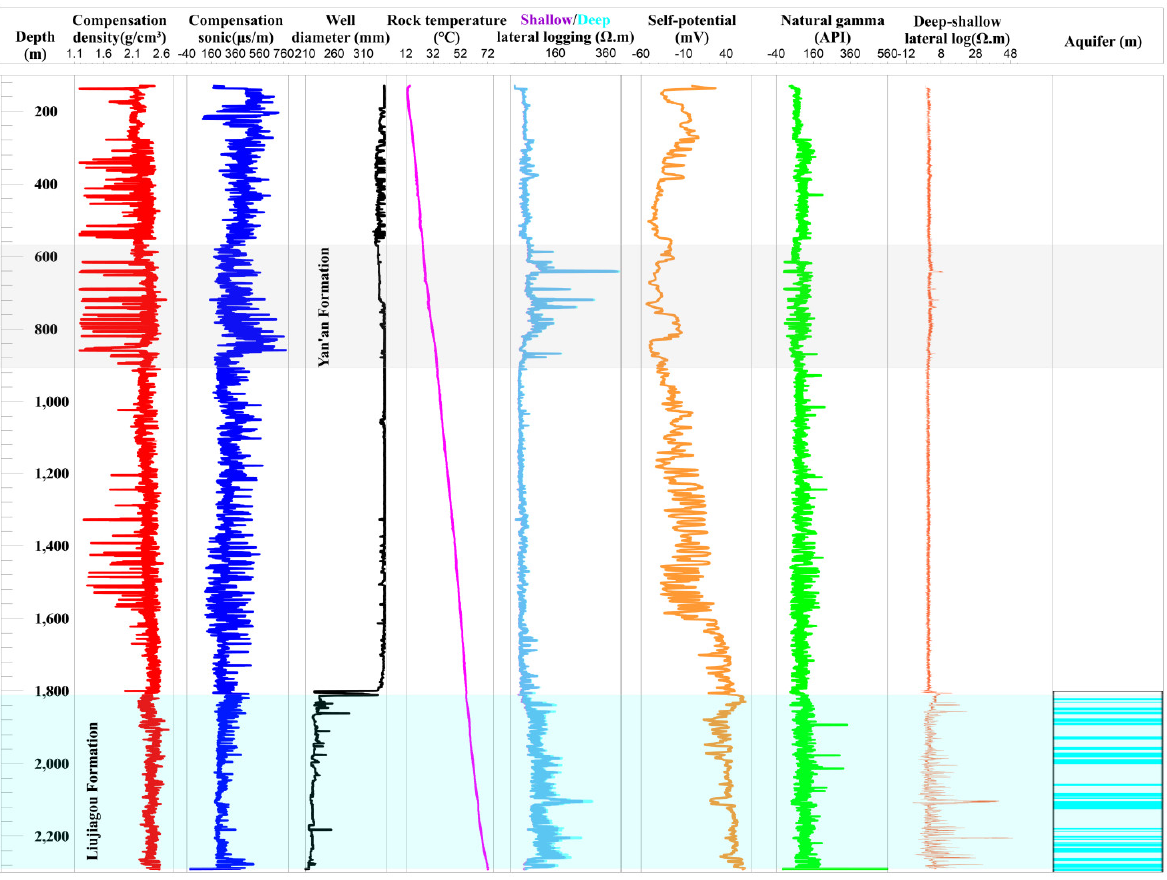
Figure 5. Geophysical logging with the various methods of compensation density, sonic, diameter, temperature, shallow/deep lateral logging, self-potential, natural gamma and deep-shallow differ- ence of lateral logging for the MC-1 well in Muduchaideng coal mine. The aquifers distribution in LFm is shown in the right column.